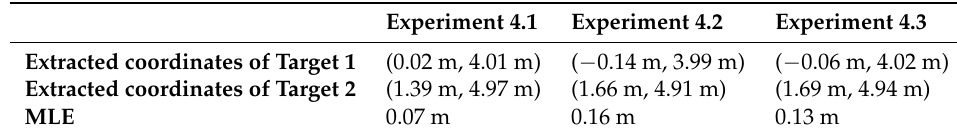
Figure 19. Photographs and geometries of Experiment 4: ( a ) Experiment 4.1 with lying posture for Target 1; ( b ) Experiment 4.2 with kneeling posture for Target 1; and ( c ) Experiment 4.3 with sitting posture for Target 1. Table 5. Localization results and MLE of Experiment